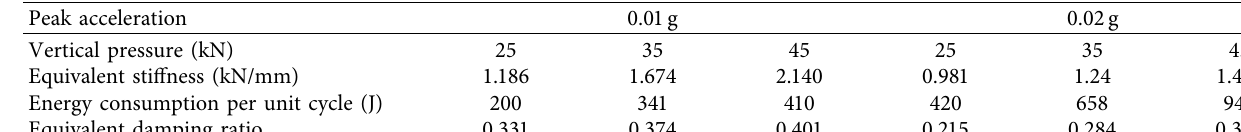
Figure 9: Energy consumption distribution of the reticulated shell structure of the isolation bearing. Table 4: Mechanical performance parameters of isolation bearings.